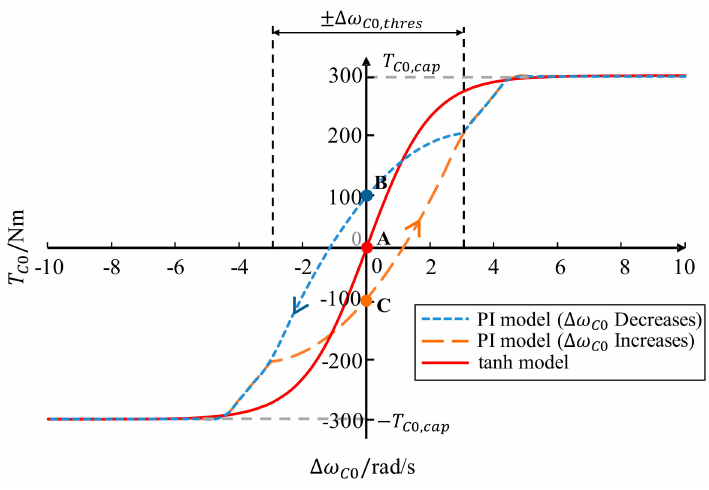
Figure 9. Comparison between PI model and tanh